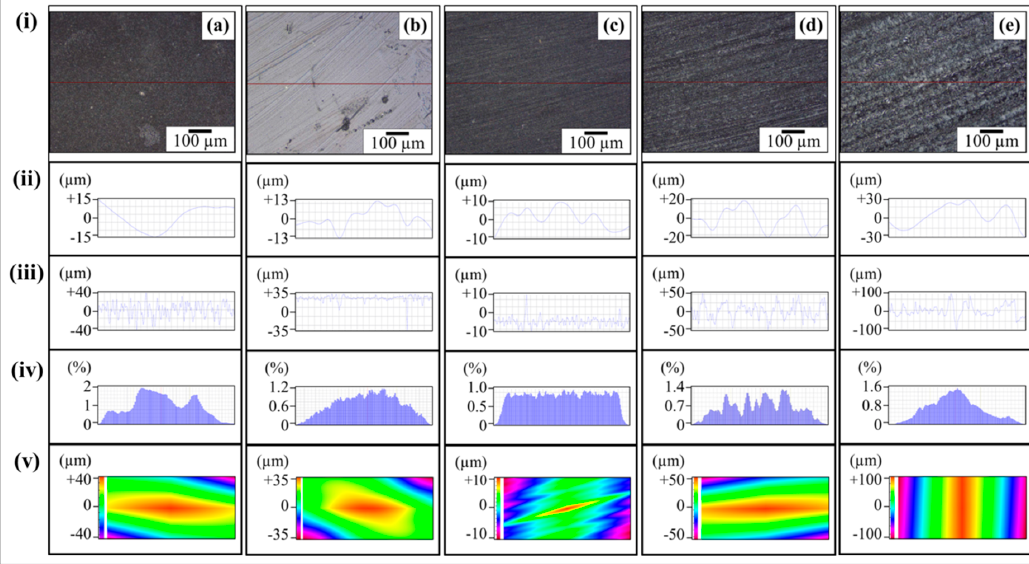
Figure 7. Topography profiles of 0.1 wt % MLG-EP nanocomposites treated with: ( a ) as-cast; ( b ) Velvet cloth; ( c ) 1200P; ( d ) 320P; ( e ) 60P. In all cases: ( i ) optical image; ( ii ) waviness; ( iii ) surface roughness of selected line; ( iv ) percentage vs. topographical dimensions; ( v ) surface profile of selected rectangular specimen.